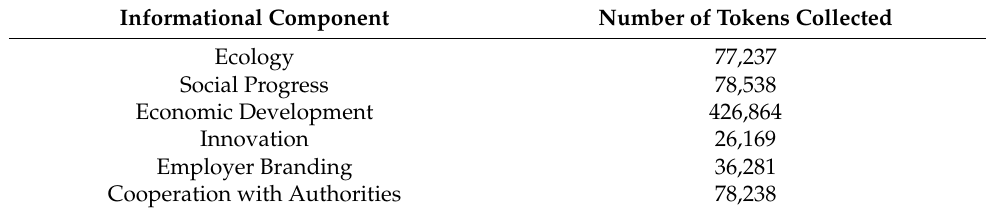
Table 2. Results of collecting informational component tokens.